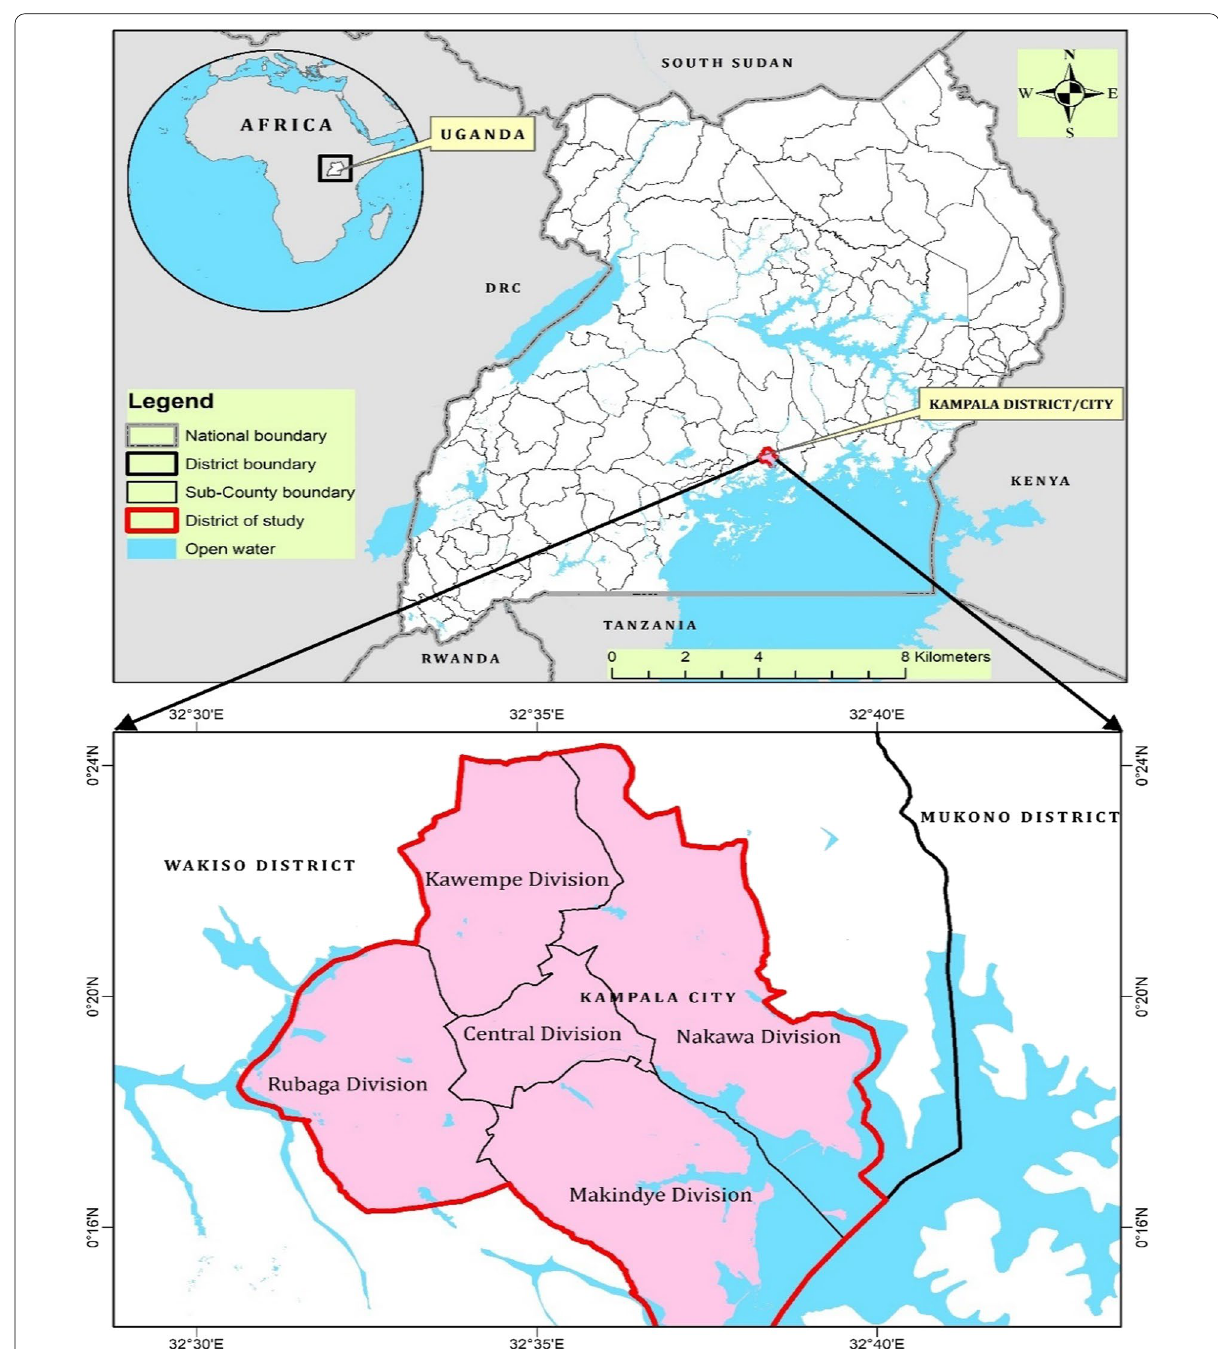
Fig. 1 Study locale: Kampala city showing the five administrative